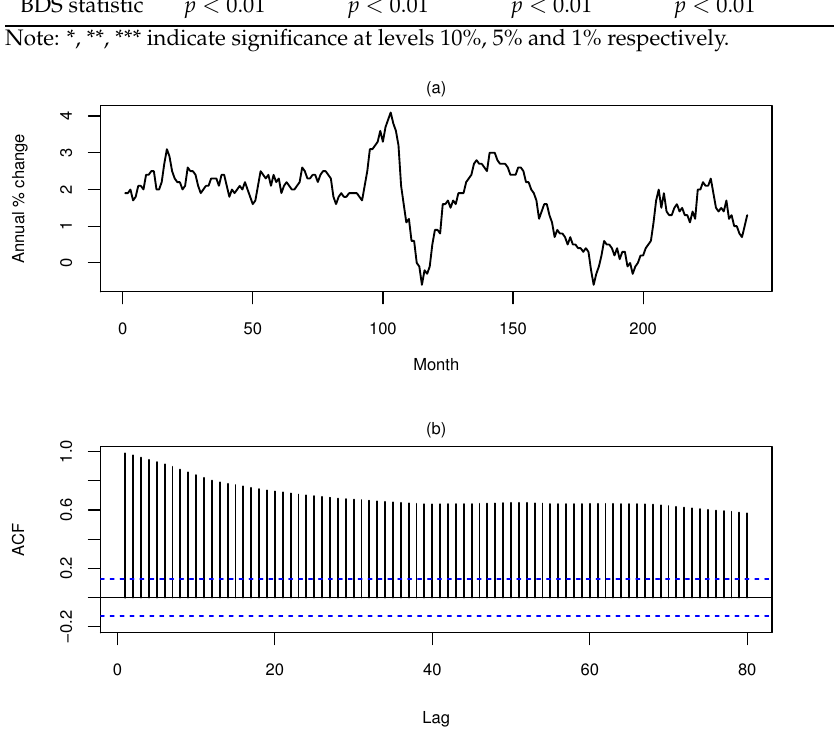
Figure 1. ( a ) Monthly data of the euro zone inflation. ( b ) Autocorrelation function.